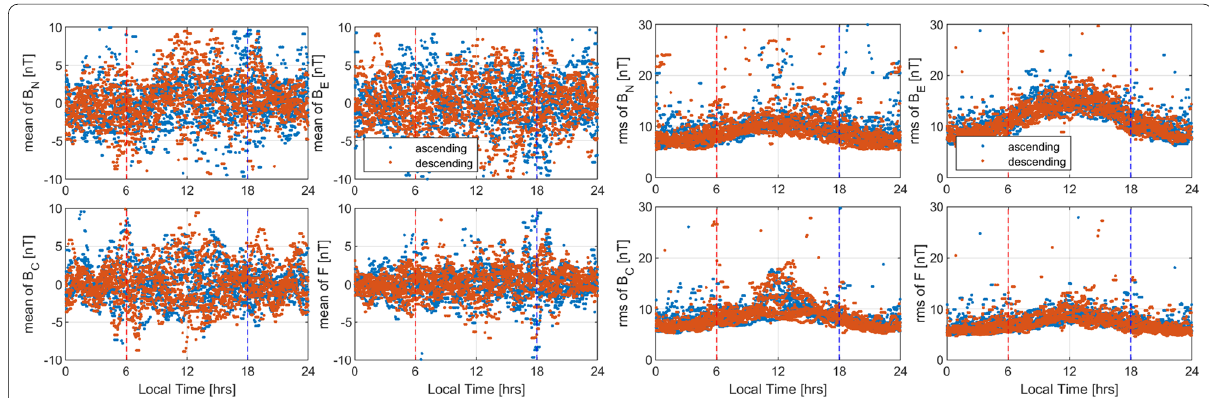
Fig. 9 Local Time dependence of GRACE-A daily mean (left) and misfit rms (right) values at non-polar latitudes for the three vector components in the NEC frame and for scalar intensity, respectively